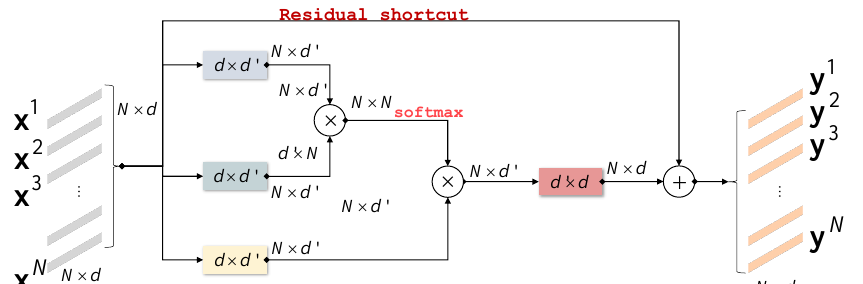
Figure 6. Inter-Region Relation (InterRR) for fully connected region features: when the feature of regions are from a fully connected layer, they will be formed as several vectors; the InterRR can be computed as a simplified version of InterRR of convolutional